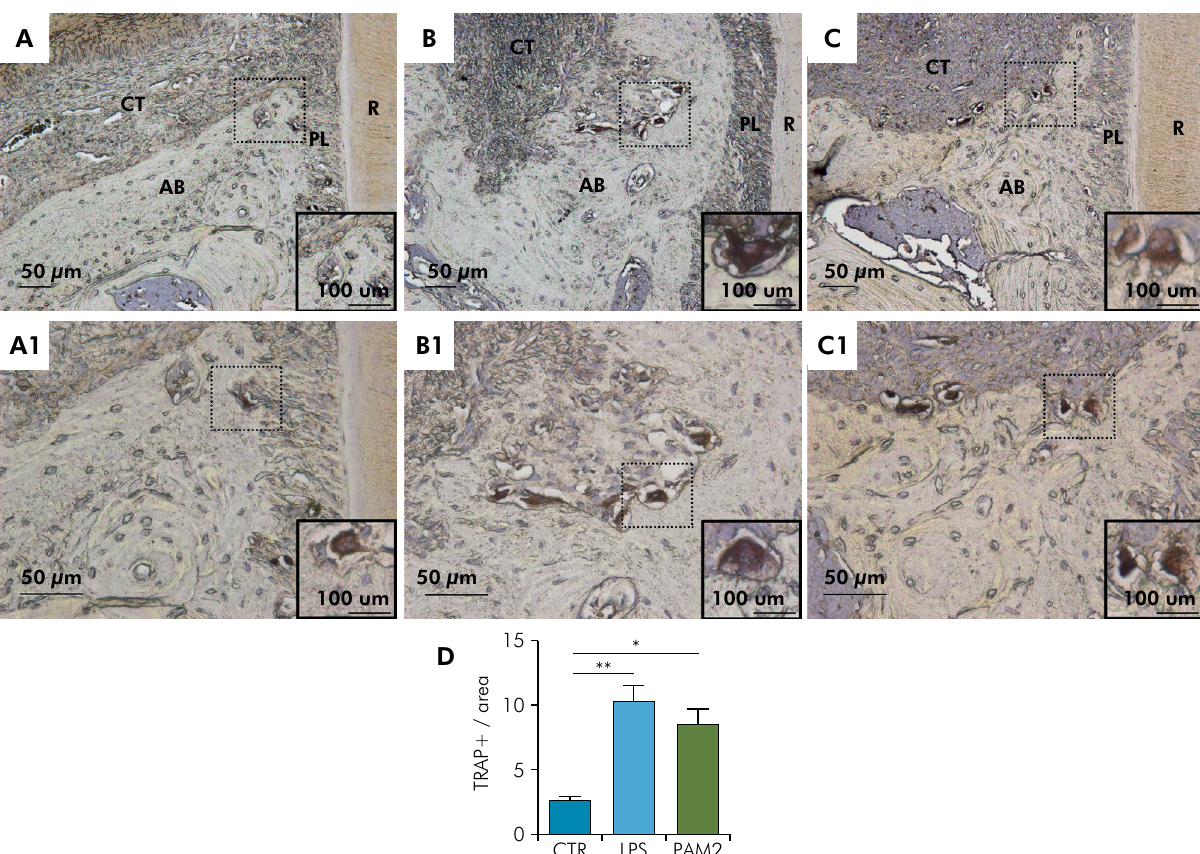
Figure 3. Counting of TRAP+ multinucleated cells. (A-C): Control (n = 7), LPS (n = 7) and PAM (n = 7) groups respectively. Original magnification, 20x. (A1-C1): Magnified views of the control, LPS and PAM groups. Original magnification, 40x. Insets are magnified views of individual TRAP+ cells in all groups; (D): Quantification of TRAP+ cell number in all mice and groups (n = 7 mice per